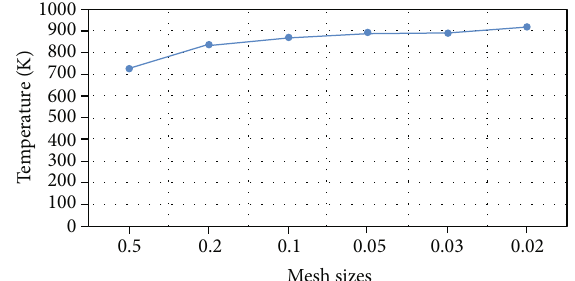
Figure 9: In fl uence of mesh size on temperature.